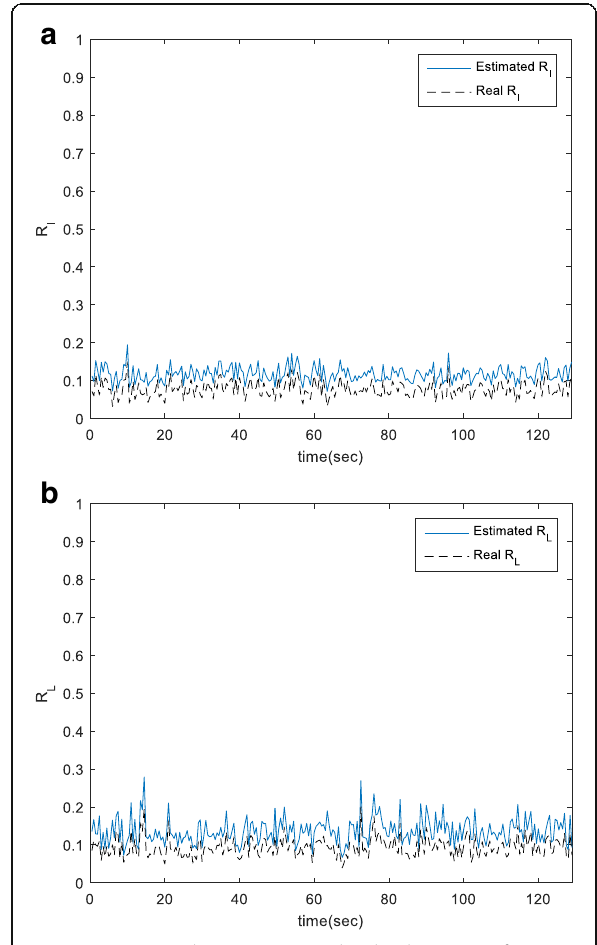
Fig. 11 Comparison between estimated and real R I , R L a interference ratio and b transmission opportunity loss ratio, a shows the interference ratio and b shows the transmission opportunity loss ratio. For each case, the solid line represents the estimated value and the broken line represents the real value. a and b are approximate to